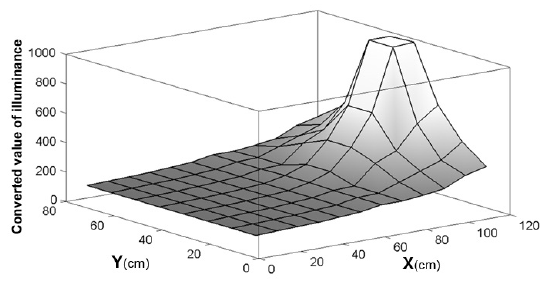
Fig. 3. Spatial distribution of luminance of arena with fluorescent lamp (about 1000